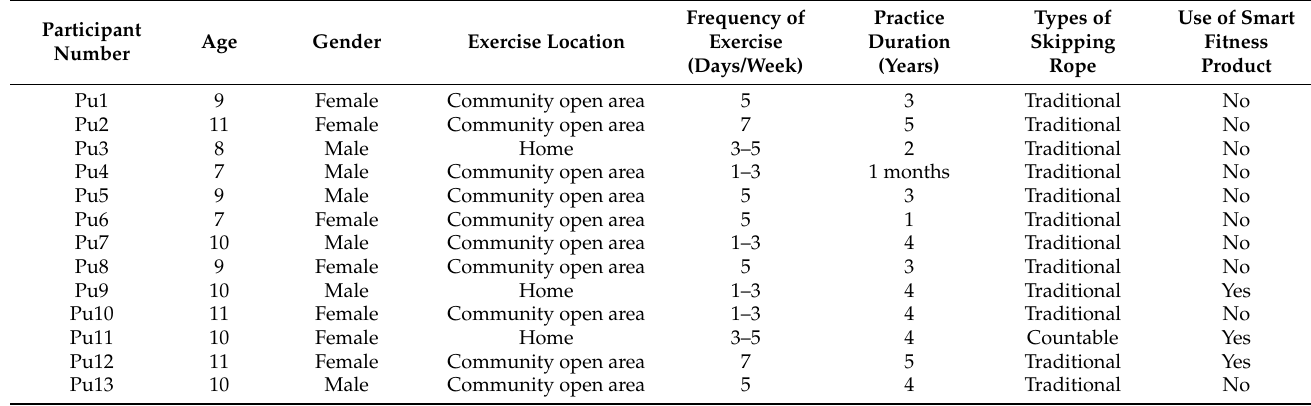
Table A1. Pupil characteristics.